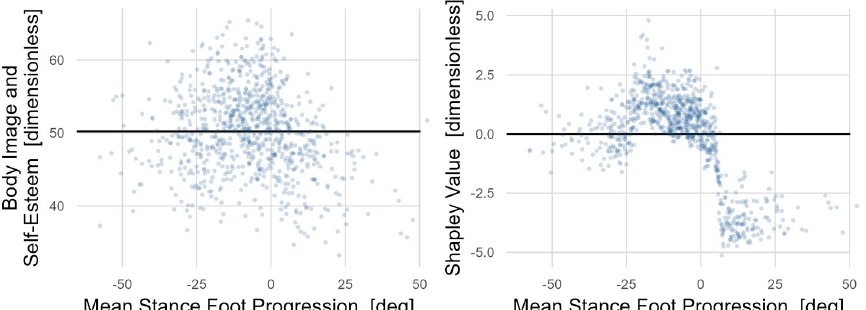
Fig 14. The impact of in- and out-toeing on Body Image and Self Esteem . Raw, non-causal (left) and causal (right) impacts of in- and out-toeing (mean stance foot progression) are shown. The raw data is widely dispersed but is suggestive of detrimental effects when deviating from typical foot alignment (around -10˚). These effects are much clearer in the causal dependence plot. Deviations in either direction from typical result in lower Body Image and Self- Esteem , but the impact of in-toeing (positive) is about twice as large as that of out-toeing. There is a precipitous drop in Body Image and Self Esteem starting at around 0˚, which is probably where in-toeing becomes easily discernable.